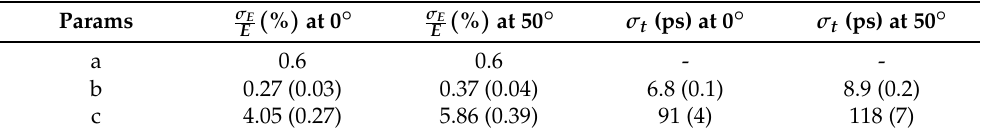
Figure 4. Operations with Module-0: ( left ), picture of Module-0 inside the vacuum vessel readout with MB and DIRAC boards; ( right ), distribution of time differences between all crystal pairs, before (blue) and after (red) T0’s calibration. Table 1. Parametrization of energy and time resolution for Module-0 electron test beam. The numbers in parentheses represent one sigma